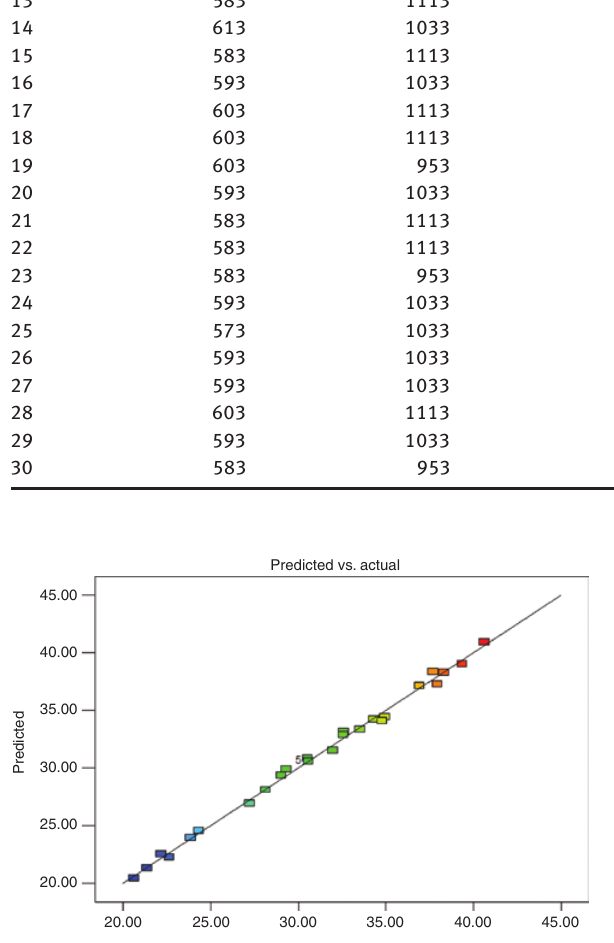
Table 2: Experimental and predicted results in CCD for the crystallite size of TiO No.